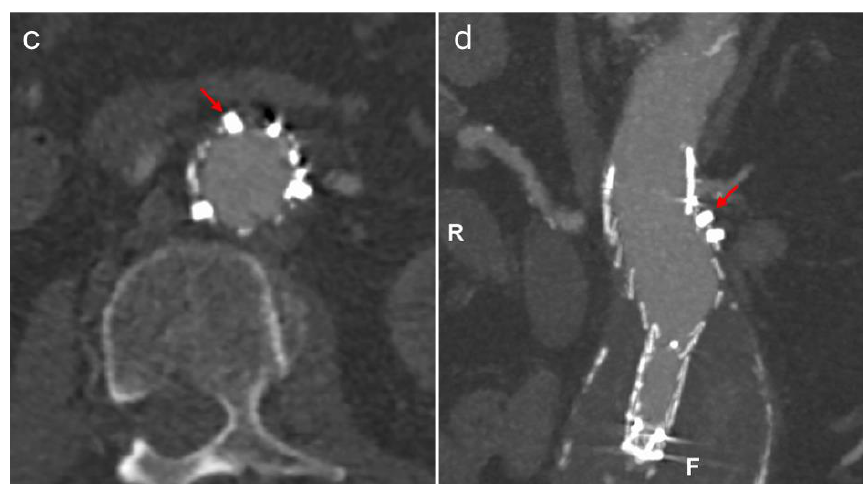
Figure 5. ( a ) Coronal oblique MIP image of an abdominal aortic aneurysm with a conical neck unsuitable for conventional EVAR. The patient was treated with EVAR with primary endoanchors (Heli-FX, Medtronic). Follow-up abdominal radiograph ( b ), axial ( c ) and coronal ( d ) CT angiogram demonstrating the endoanchors attaching the proximal stent graft to the aneurysm neck (red arrows).